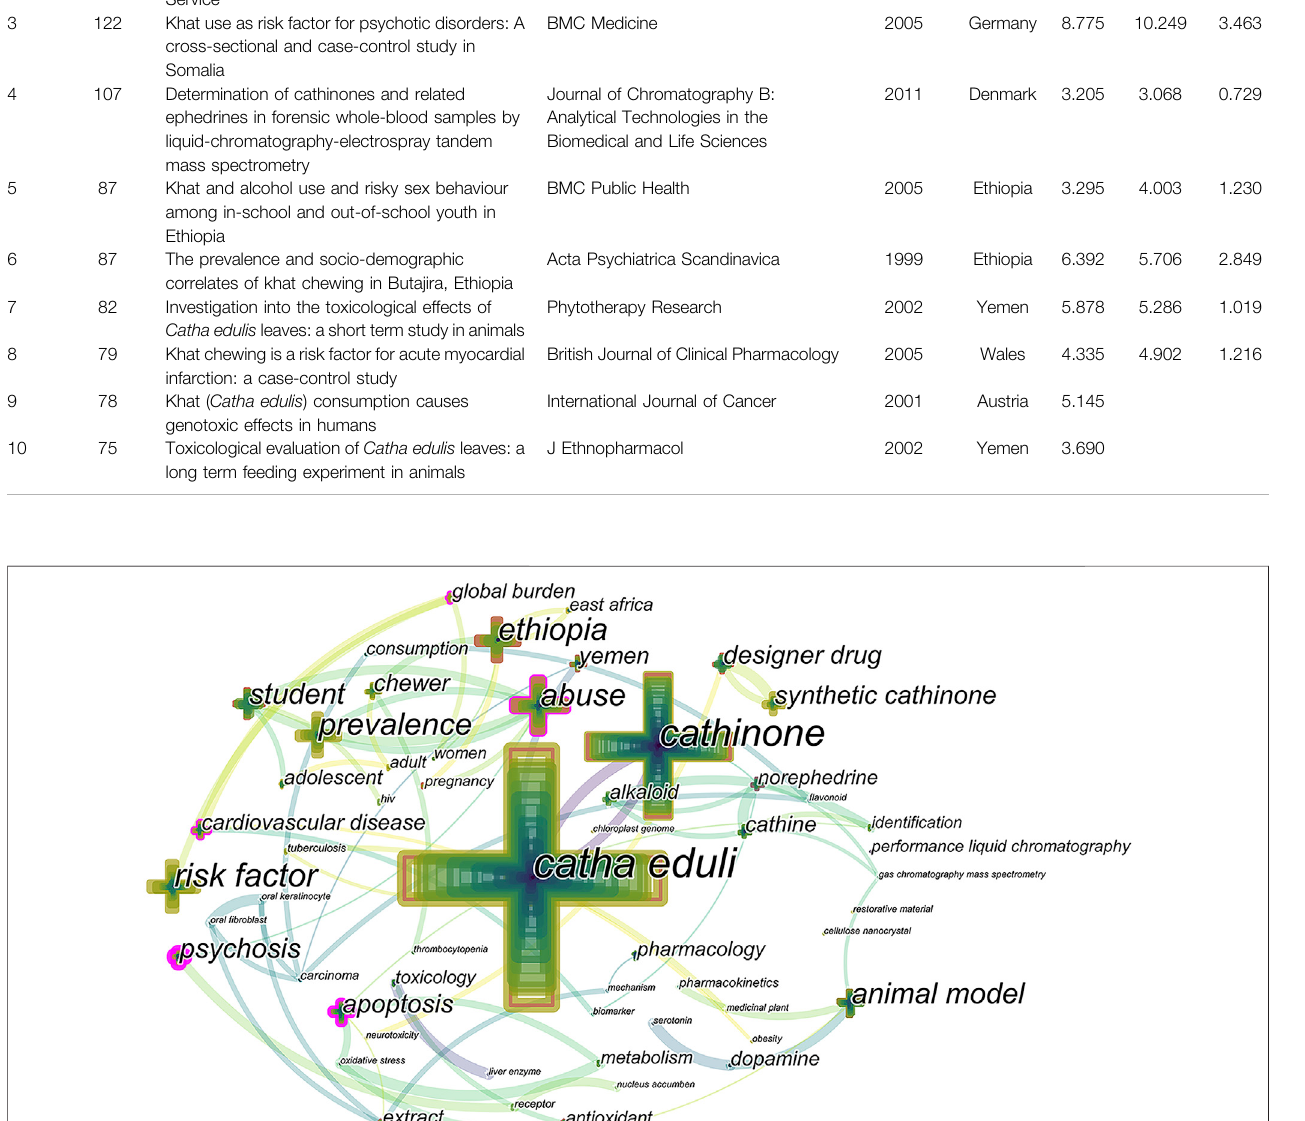
Frontiers in Pharmacology |